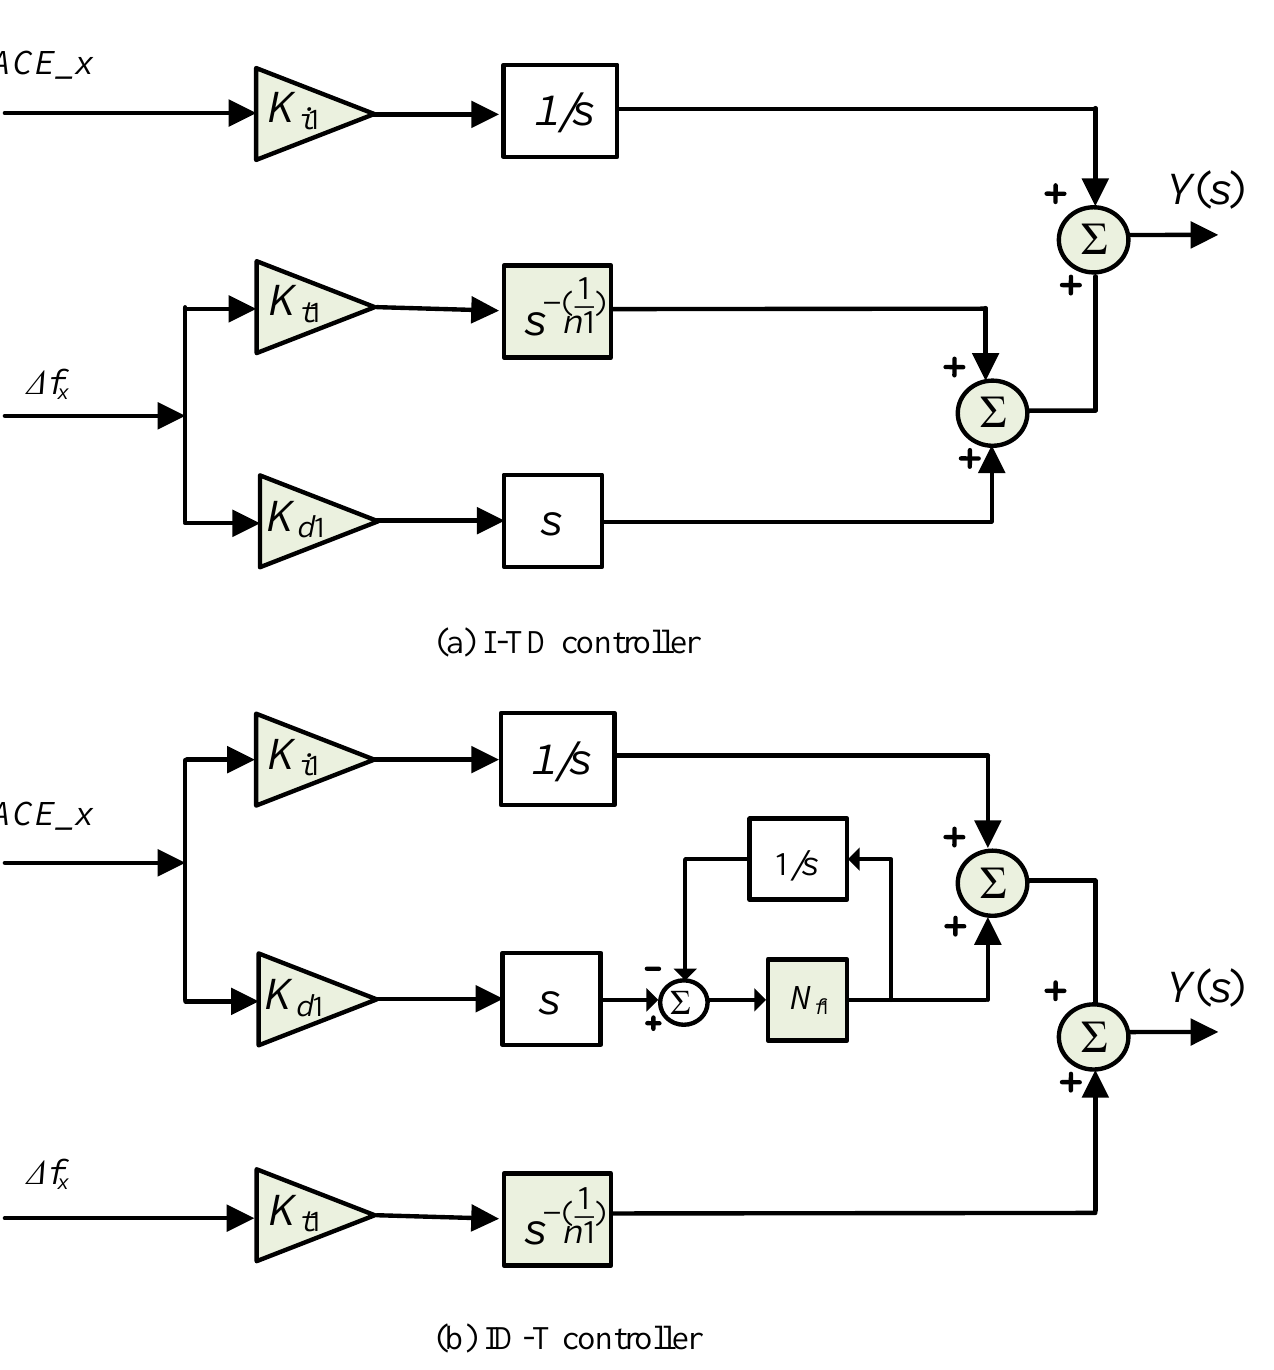
Figure 4. The conventional I-TD and ID-T LFC